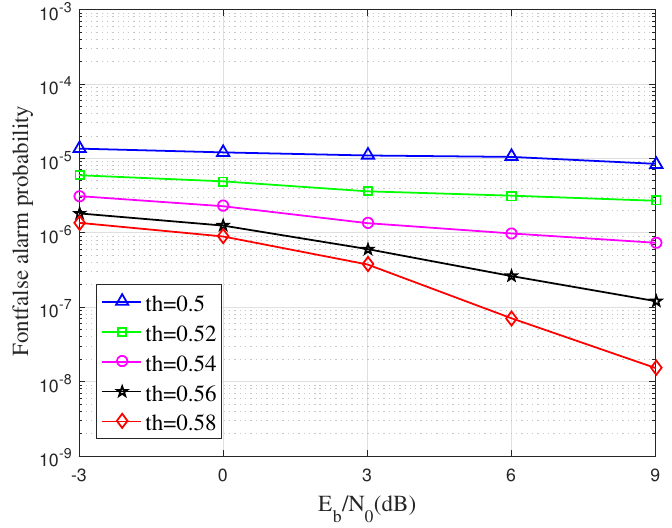
Figure 12. False alarm probability of DUWDC under different SNR.